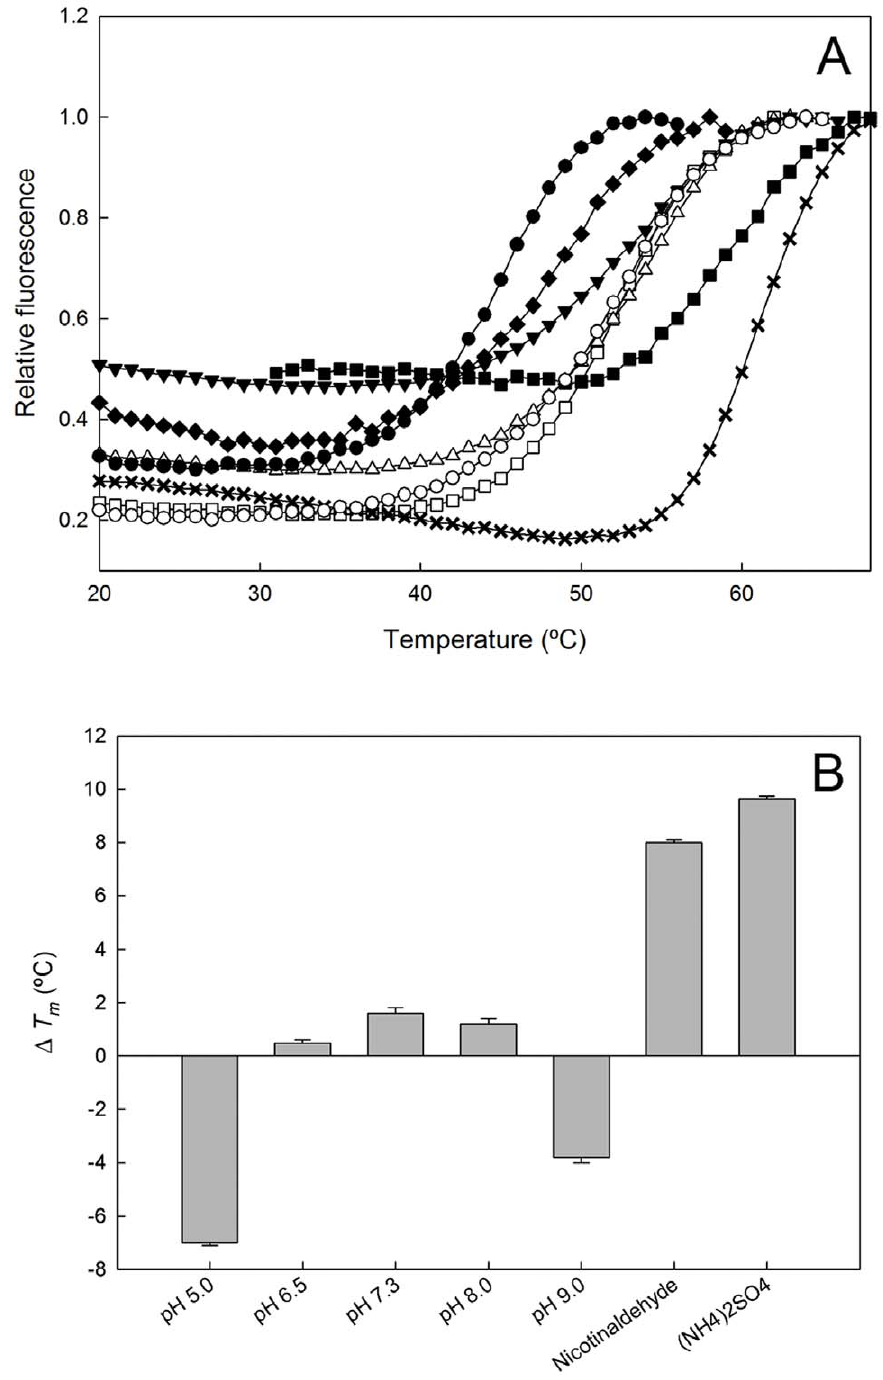
N Figure 3. Thermal stability of OiNIC. A) Melting temperature curves of purified enzyme (1 m g) were obtained in the presence of fluorescent ), 100 mM sodium phosphate pH 6.5 ( % ), pH 7.3 ( D ), pH 8.0 ( . ), probe SYPRO Orange in Milli Q water ( # ), 100 mM sodium acetate pH 5.0 ( 100 mM TRIS-HCl pH 9 ( ¤ ), 1 mM nicotinaldehyde ( & ) and 1 M ammonium sulfate (x) prepared in 100 mM sodium phosphate pH 7.3. B) Effect of different modulators on the melting temperature of OiNIC. Differences in D T m were calculated subtracting MilliQ H T m value from the T m values obtained for the enzyme under the different conditions used above. doi:10.1371/journal.pone.0056727.g003 (C133A/F68W) combining the two latter mutations was con- mutants was observed, since both changes gave rise to a higher k cat structed in order to obtain more activity towards PZA. However, for PZA (5.21 6 0.01 s 2 1 ) but also a higher K m (0.83 6 0.03 mM). no improvement in the catalytic efficiency compared with single Finally, mutation at position E65H, which affects the fourth residue involved in ion metal binding, produced a dramatic loss in PLOS ONE |